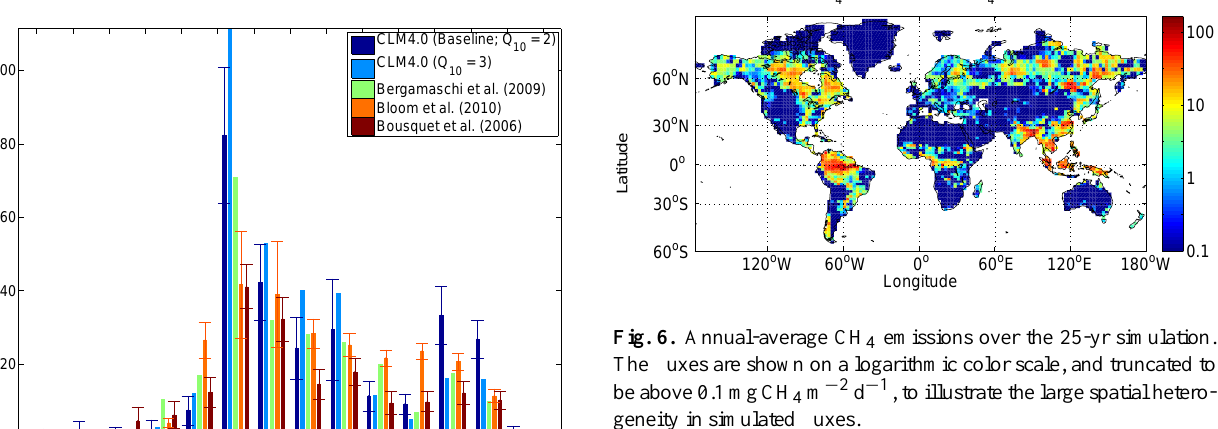
17 cm in the same gridcell, the simulated net CH 4 flux did not decrease with increasing aerenchyma